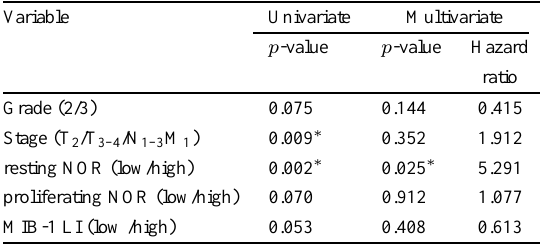
Comparison of the prognosis using univariate and multivariate anal- ysis for